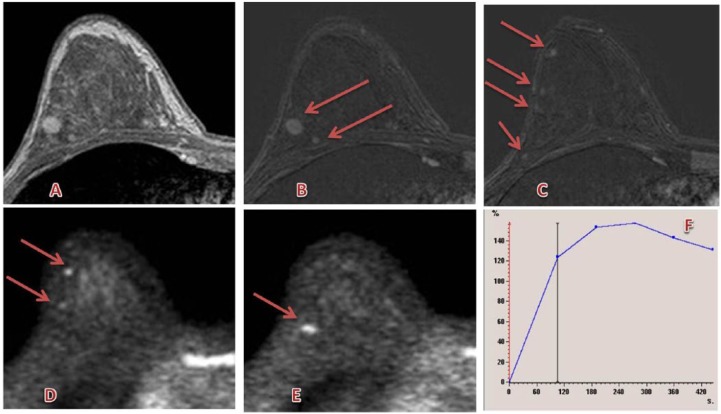
Multicentric left breast lesion (the greater of about 3.5 cm) between upper quadrants with irregular lobulated margins, restricted diffusion, and early and strong enhancement (lobular carcinoma). (A, B) T2 images; (C, D) diffusion-weighted images; (E-G) postcontrast subtracted images; and (H) enhancement curve. Contrast agent: gadobutrol, 9 mL. Courtesy of Professor De Cobelli, Radiology Department, San Raffaele Scientific Institute, Milan.